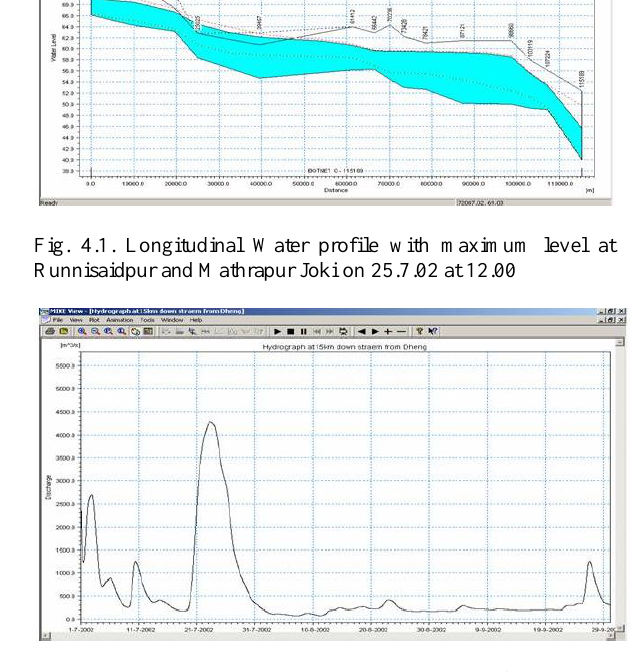
Fig. 4.2: Hydrograph at the cross section, 15km.d/s from Dheng